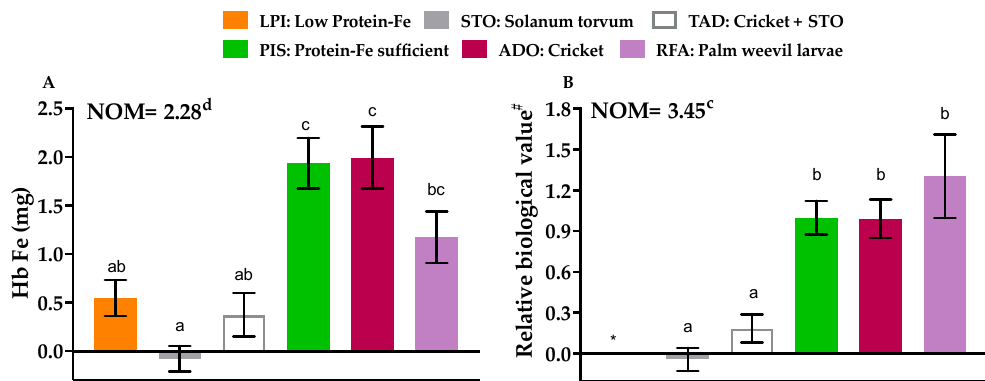
Figure 4. Effects of protein-Fe supplementation on hemoglobin. ( A ) Hemoglobin iron ( B ) Relative biological value (RBV). # RBV was compared to the PIS group. * RBV too low to calculate. Data are presented as means ± SEM, n = 8, means with different letters differ ( p < 0.05) according to Tukey’s